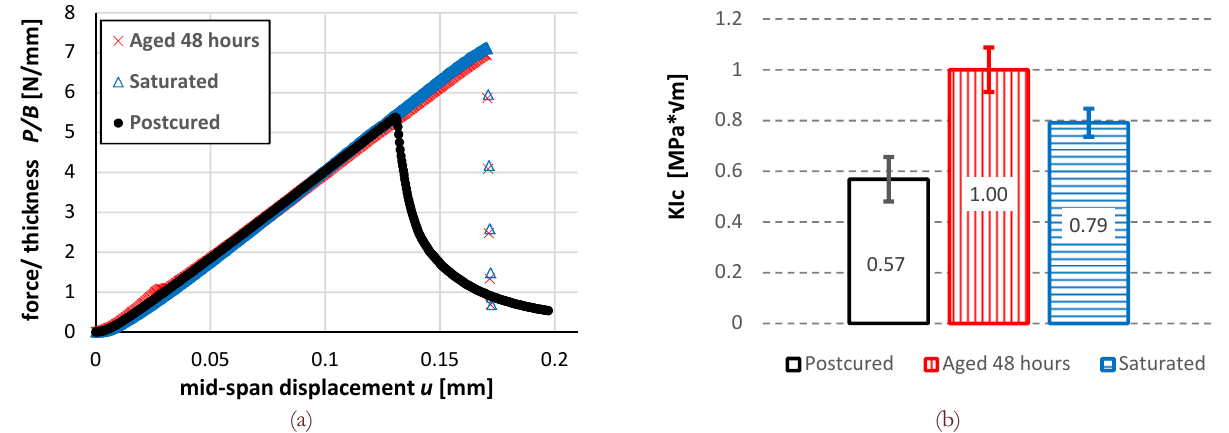
Figure 6: (a) Plots of normalized force versus displacement from SENB samples; (b) Value of KIC fracture toughness measured at the three monitored conditions.